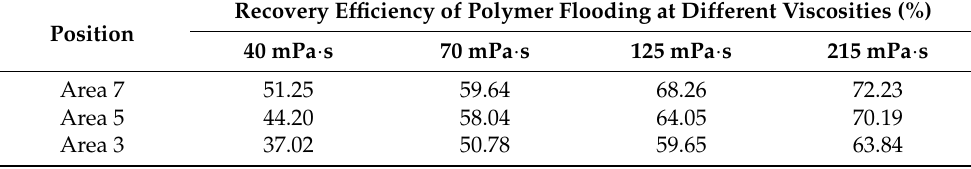
Table 3. Changes in recovery factors in different areas of the mainstream line.